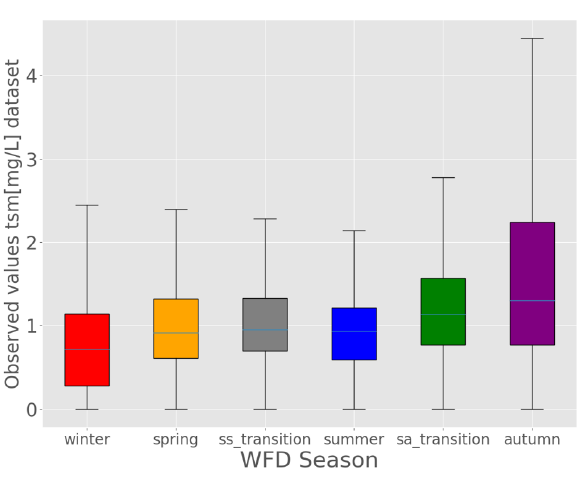
Figure 5. Histograms per season- TSM (three lakes).